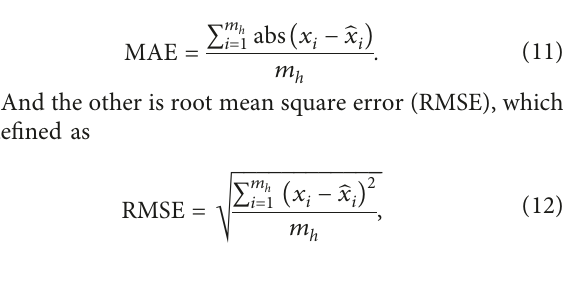
Figure 3: Three-dimensional scatterplots of T a -mean . Longitude is the X axis, latitude is the Y axis, and T a -mean is the Z axis. The observations of T a -mean of (a) VE, (b) SS, (c) AE, and (d) WS were projected onto the XZ (green dots) and YZ (blue dots) planes to analyze the trends of them. According to the 3D scatterplots and projections, a polynomial with order of 2 was used to fit the trend surfaces of the